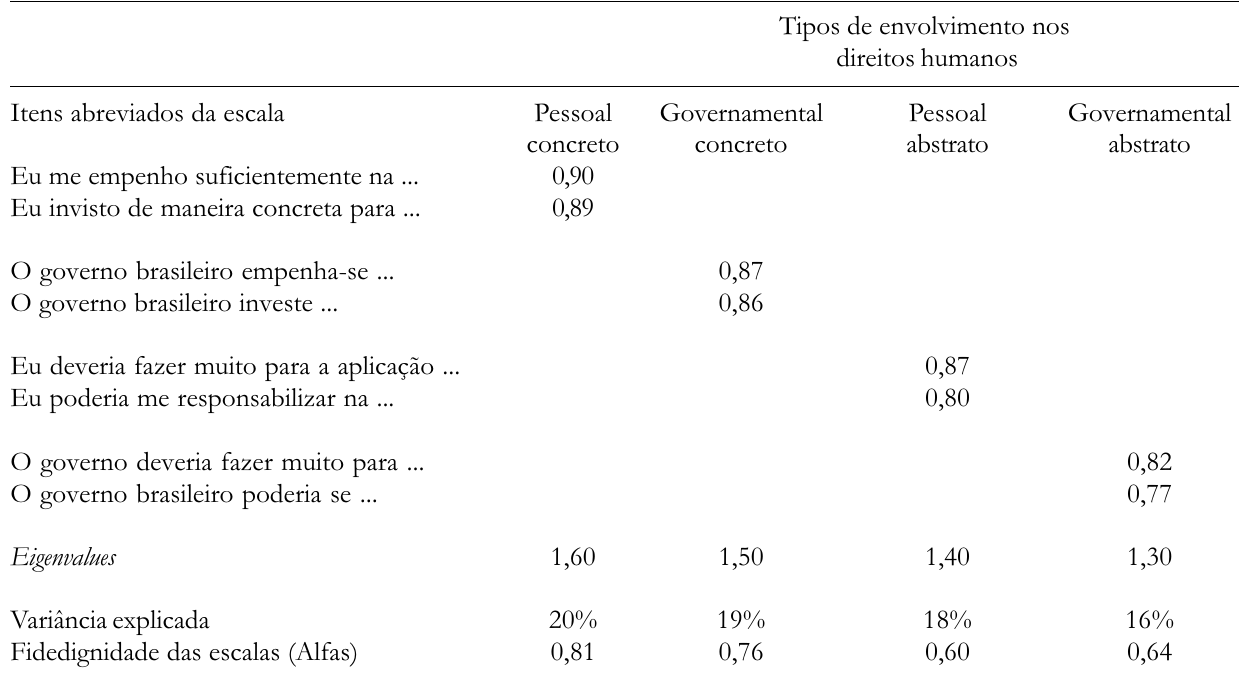
direitos humanos